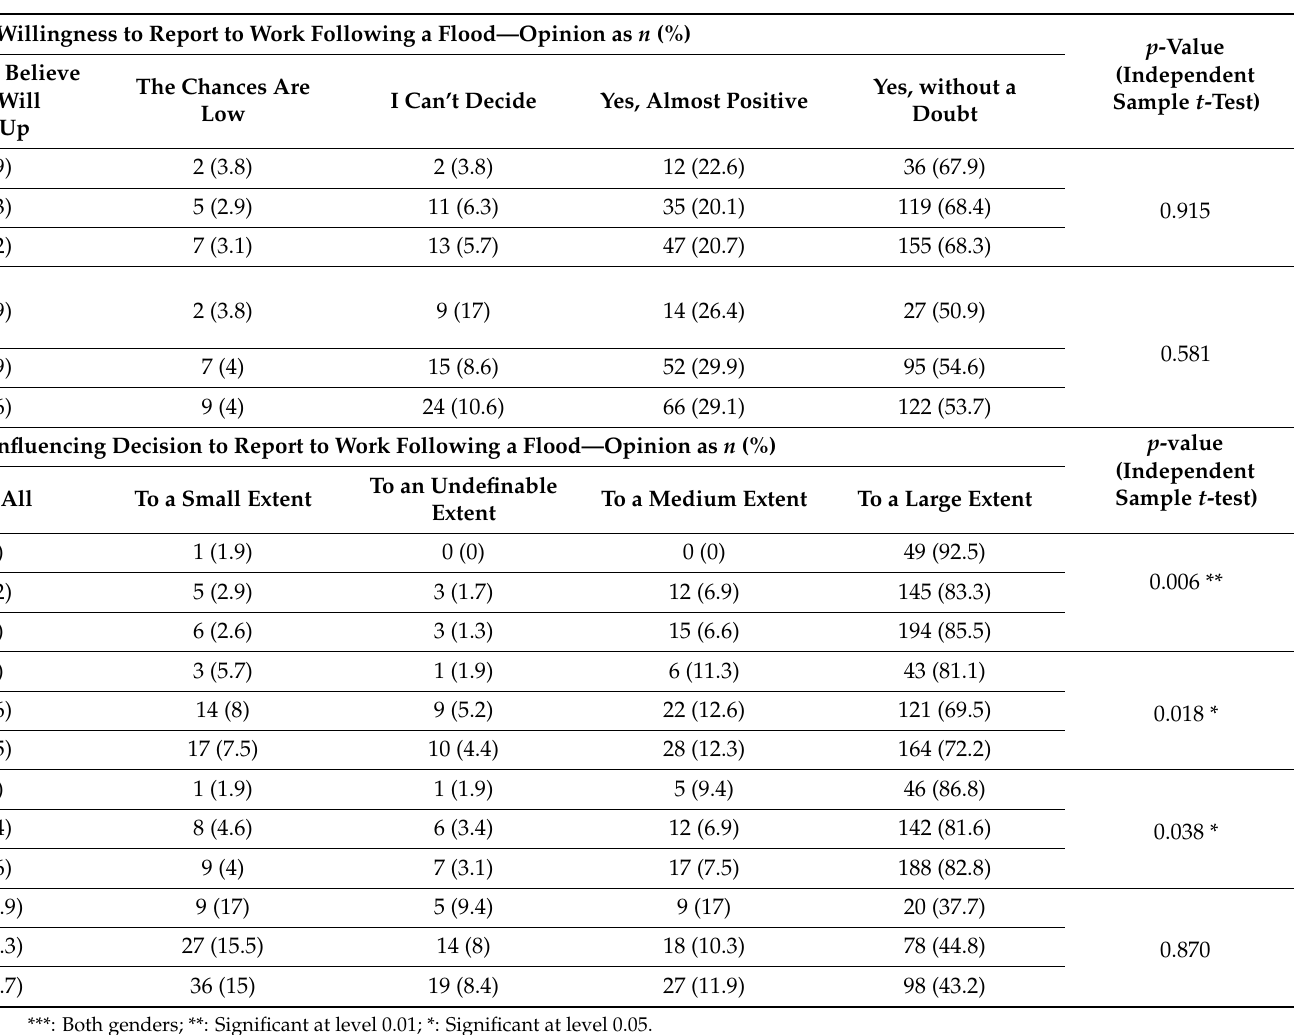
Table 3. Factors influencing decisions and willingness to report to work after